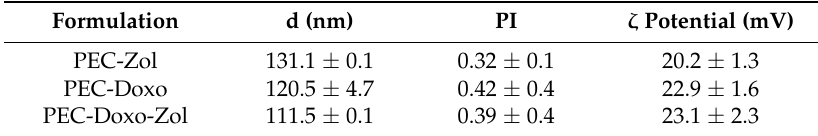
Table 5. Size, PI, and ζ potential values of different loaded PEC